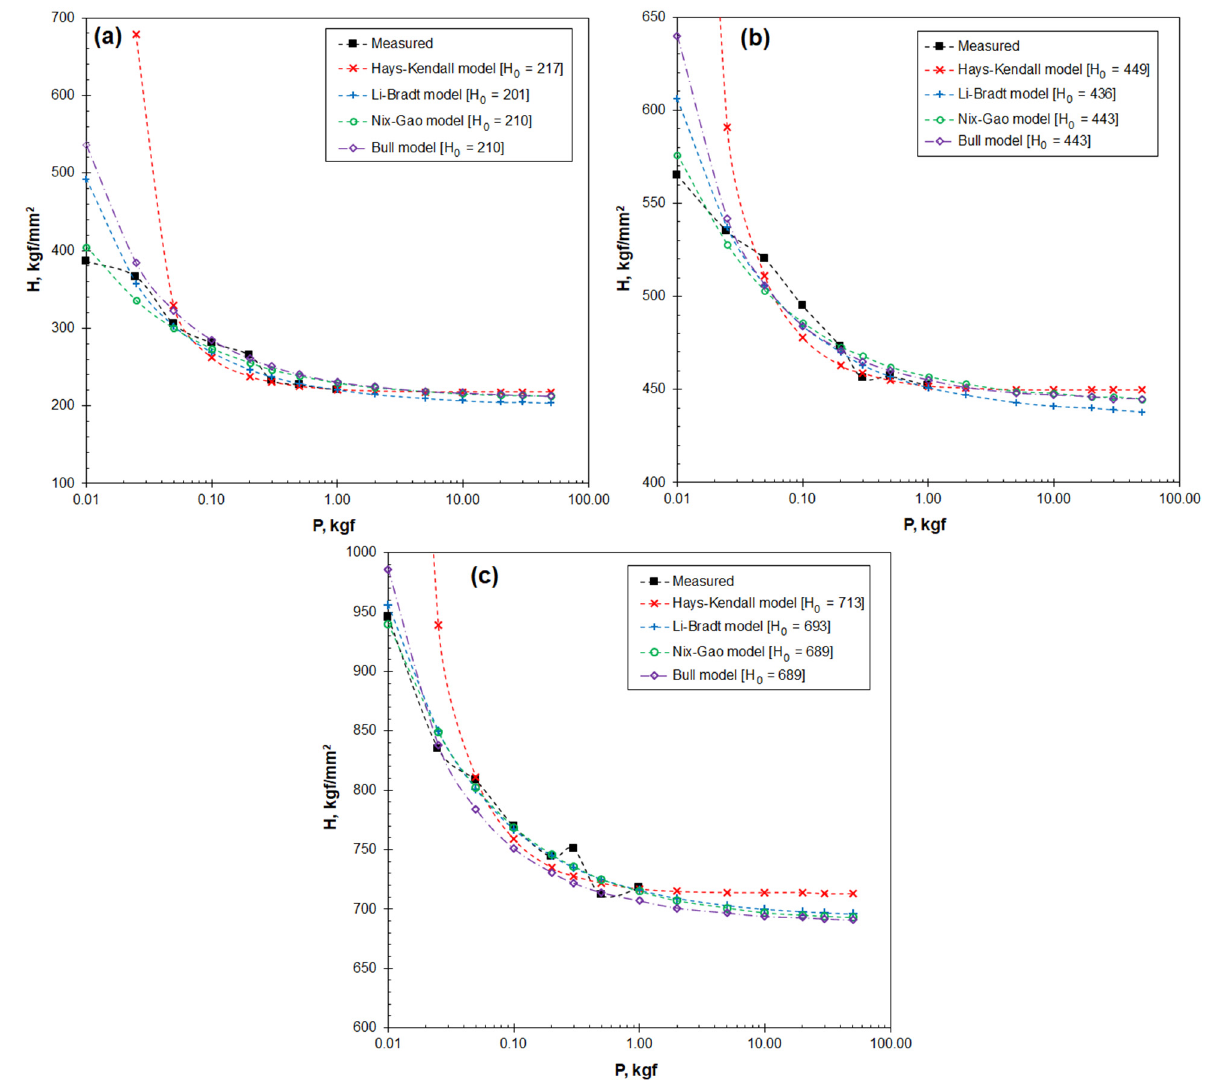
Figure 8. Comparison between the measured hardness and the hardness projected using the theoretical models: ( a ) the bulk steel; ( b ) the 47% − elongated tensile bar; and ( c ) the rail top. Table 5. The absolute difference ( ∆ H ) between the projected and measured hardness in the load